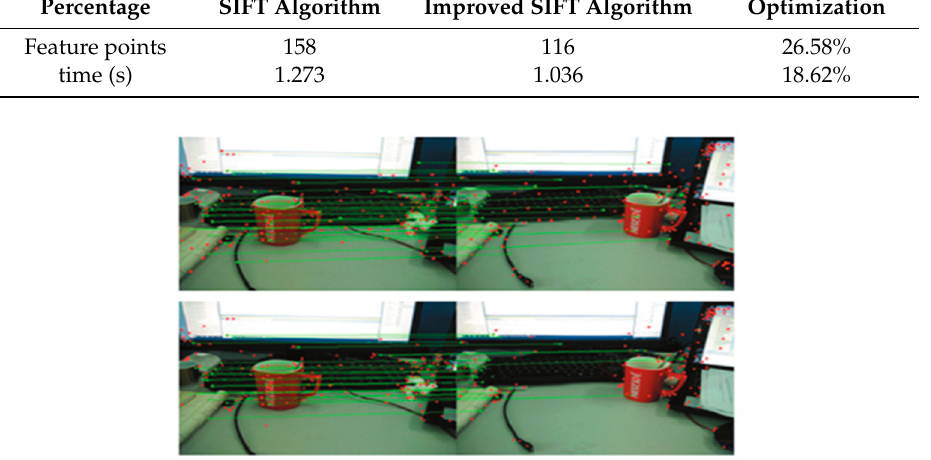
Figure 6. Comparison of matching results (example 2, the dataset of the images used in the experiment is from the Technical University of Munich, Germany). Table 2. Comparison of matching result (example 2).